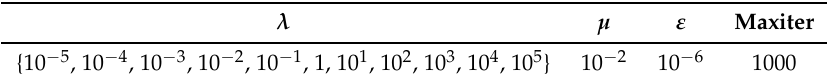
Table 1. Common parameter setting of the proposed SU-NLE, SUnSAL and CLSUnSAL for synthetic